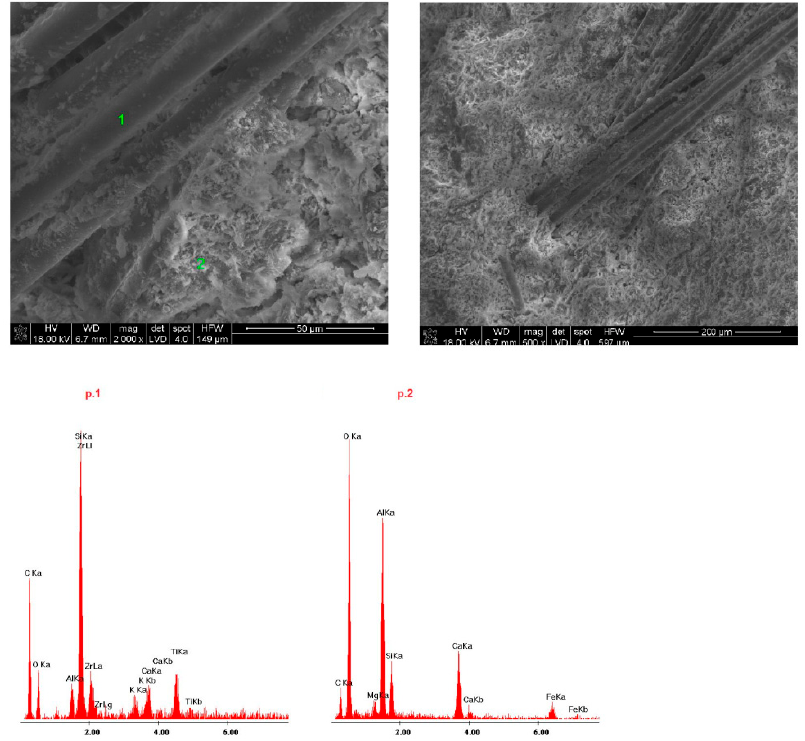
Figure 13. SEM microphotograph and EDS analysis of sample 5.